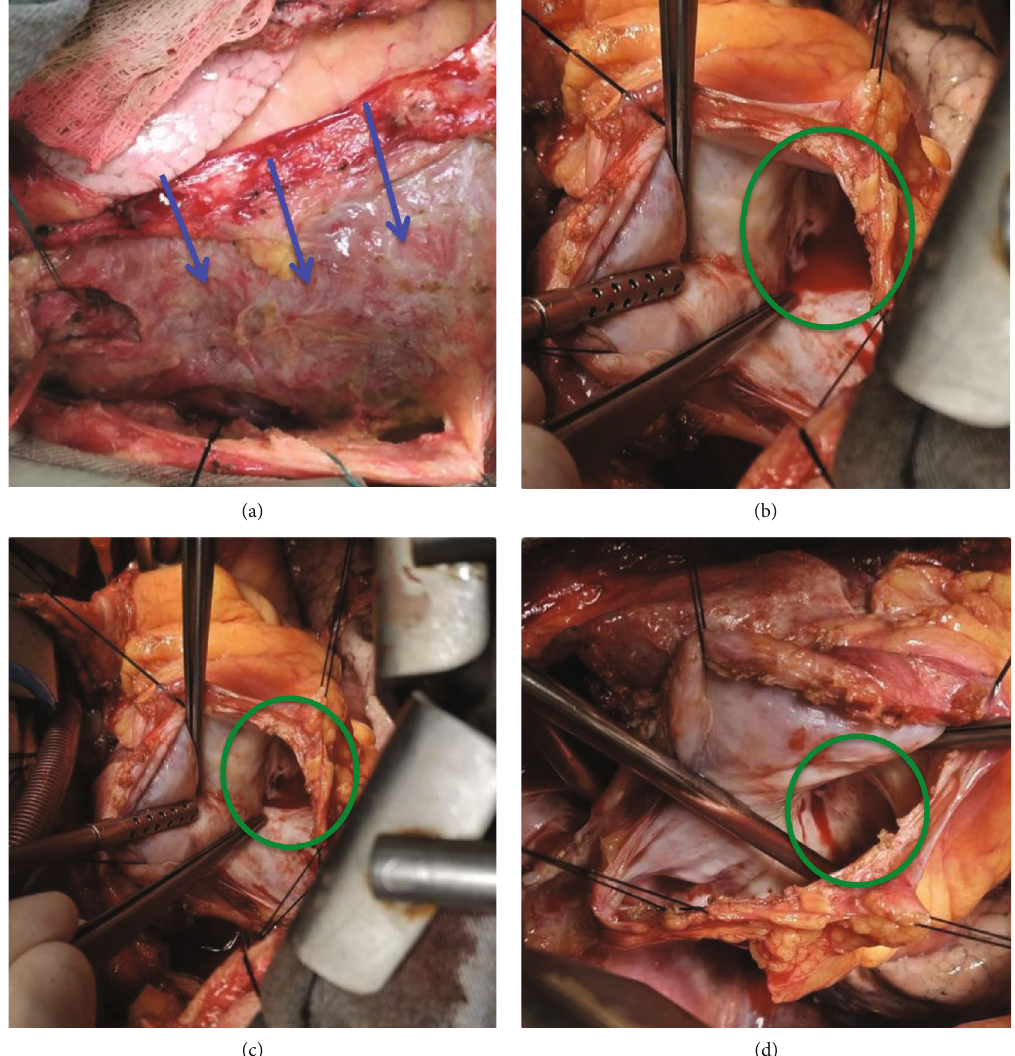
Figure 4: Intraoperative view. (a) Severe thickening of the pericardium with adherence of its layers (blue arrows), as commonly seen in constrictive pericarditis. (b – d) Rupture of the left ventricle (green circles) communicating the chamber and the pericardial